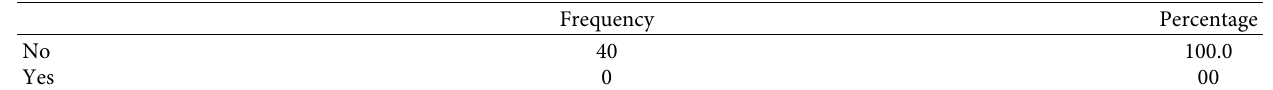
Figure 5: The fate of damaged and overripe fruits and vegetables, n � 40. Table 5: Knowledge of postharvest handling